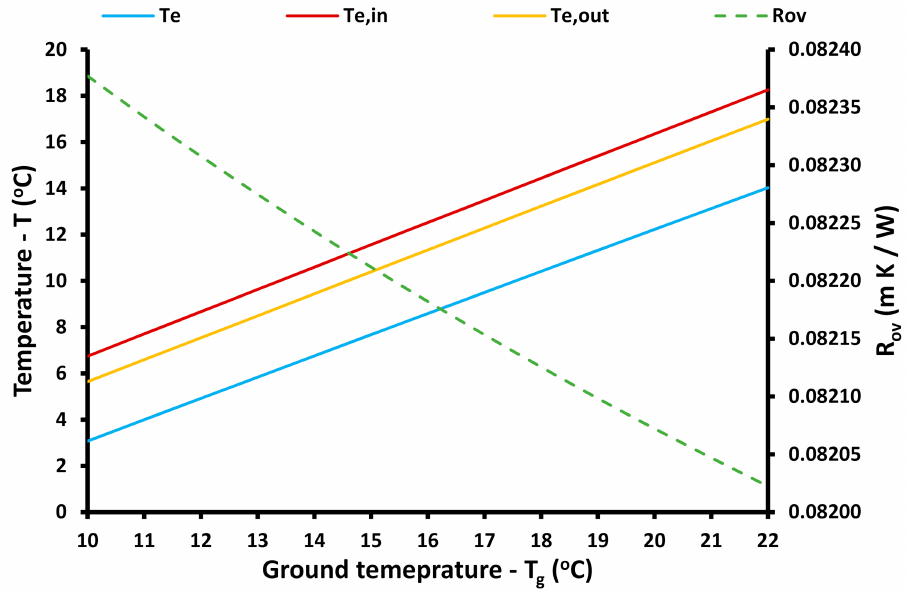
Figure 15. The impact of the ground temperature in the evaporator on the evaporator temperature levels and on the overall